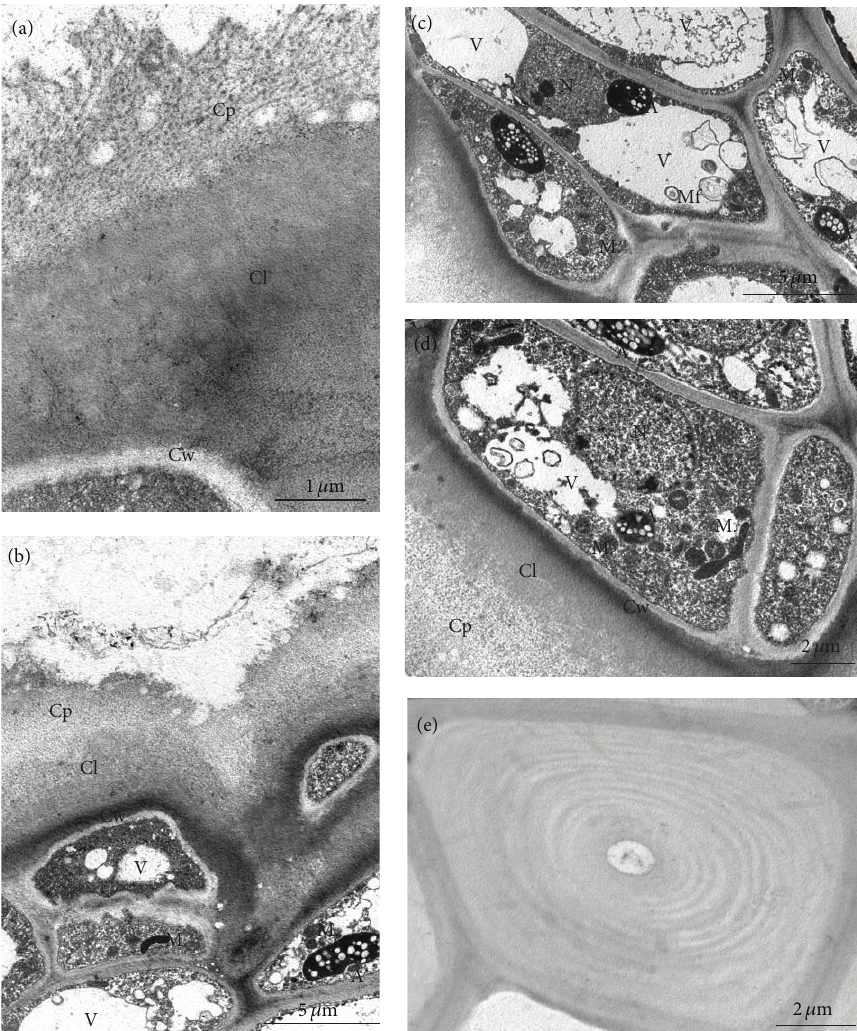
Figure 9: TEM: ultrastructure of the “Conference” fruit peel at the harvest maturity stage; (a) fragment of the fruit cuticle; (b) fragment of epidermis with cuticle and hypodermis; (c) epidermis cells with myelin figures and fibrous residue in the vacuoles; (d) epidermis and hypodermiscells;(e)stonecellsinthehypodermis;Cp:cuticleproper,Cl:cuticularlayer,A:amyloplastswithstarchgrains,M:mitochondrion, Mf: myelin figures, V: vacuoles, and Cw: cell